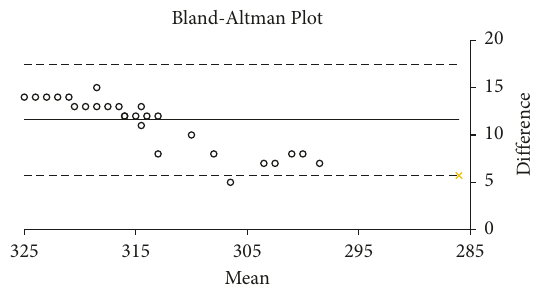
Figure 5: Bland–Altman plot for the correlation between tear osmolarity measurements taken using the TearLab and I-Pen systems in the study (smokers) group.